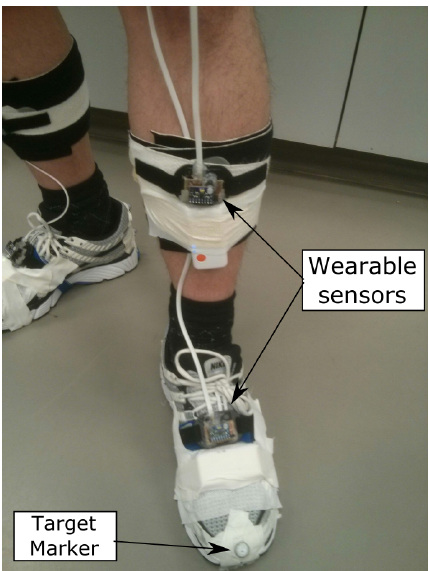
Figure 7. Wearable sensors mounted on the shank and foot with a Vicon marker for optical motion capture system [43].